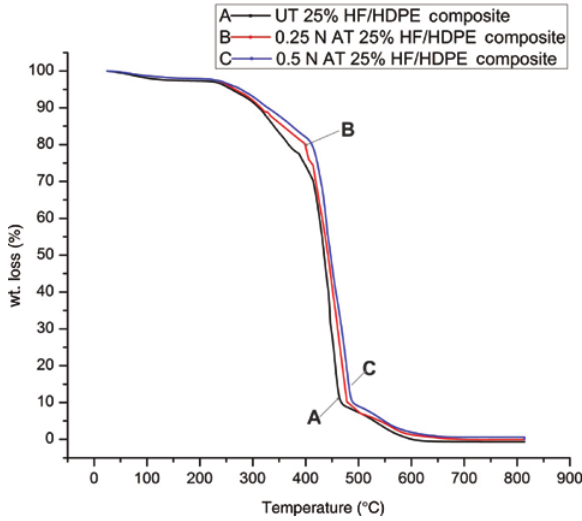
Figure 6: TGA thermograms of untreated and treated 25% HF/HDPE